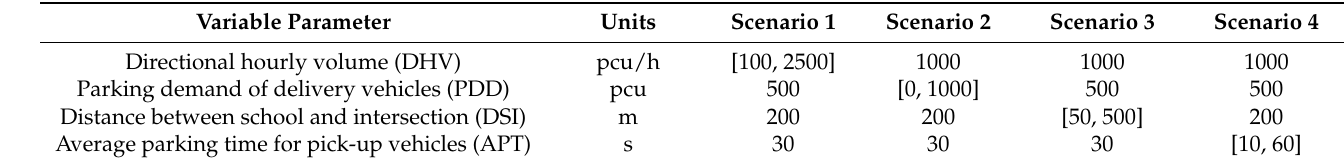
Table 4. Parameter setting of simulation